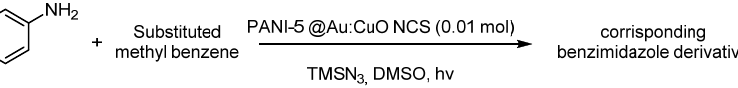
Figure 3. Pentacenequinone